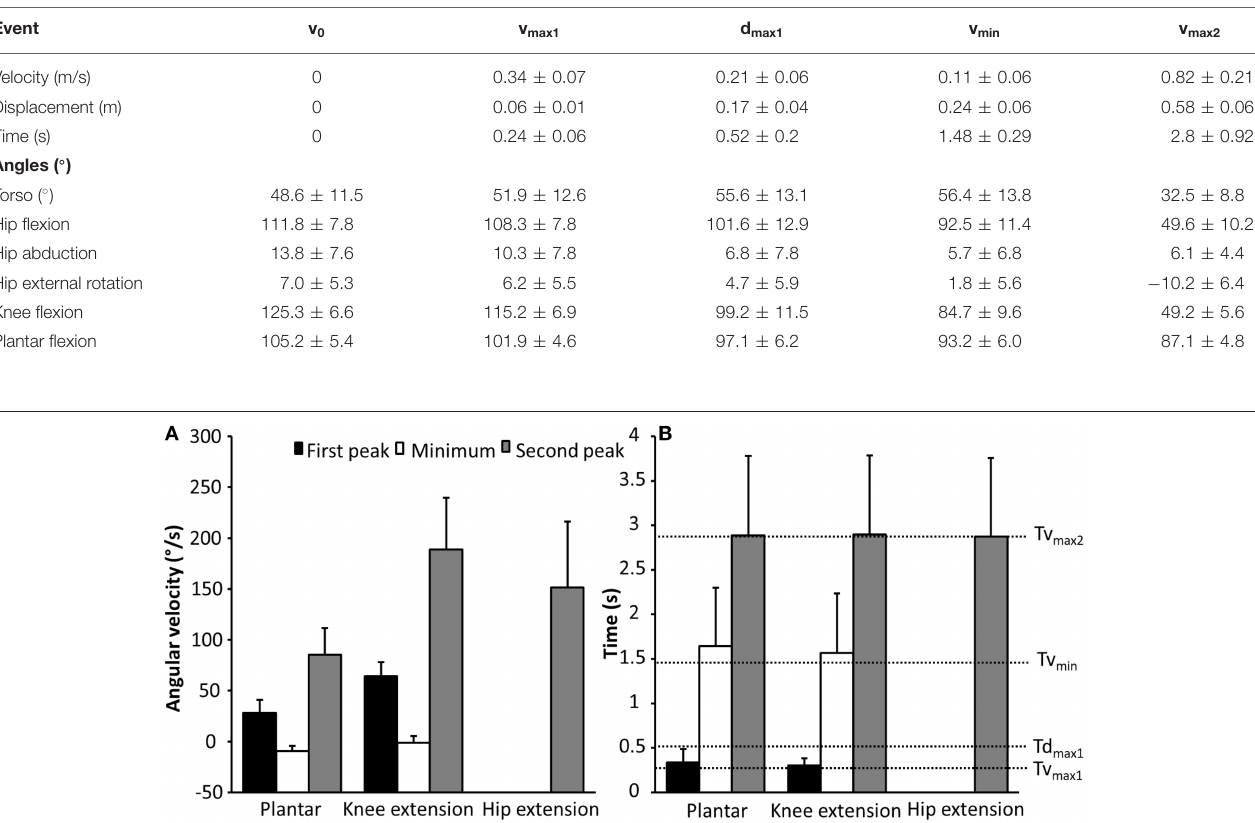
TABLE 1 | Mean ± SD barbell displacement, time, and velocity in the events v 0 , v max1 , d max1 , v min , and v max2 together with torso flexion, hip flexion, hip abduction, and external rotation, knee flexion angle, plantar flexion angles during the last repetition in 3-RM back squats.